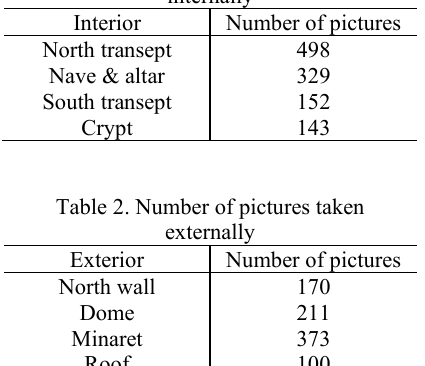
Table 1. Number of pictures taken